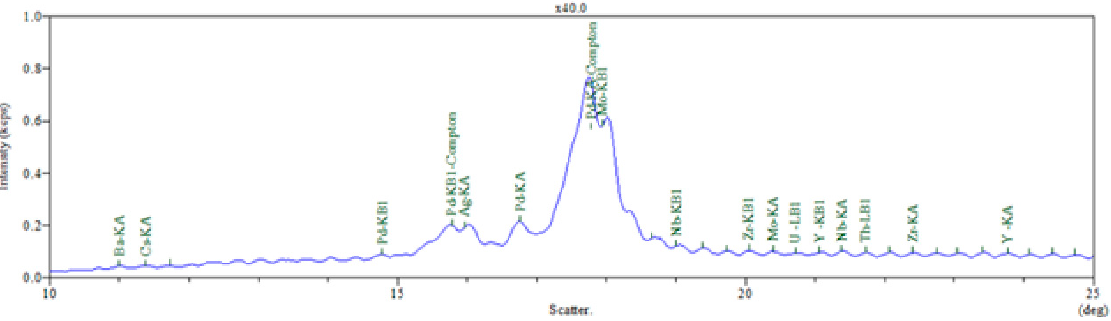
Figure 3. WDXRF for PPW. Table 3. Elemental composition of